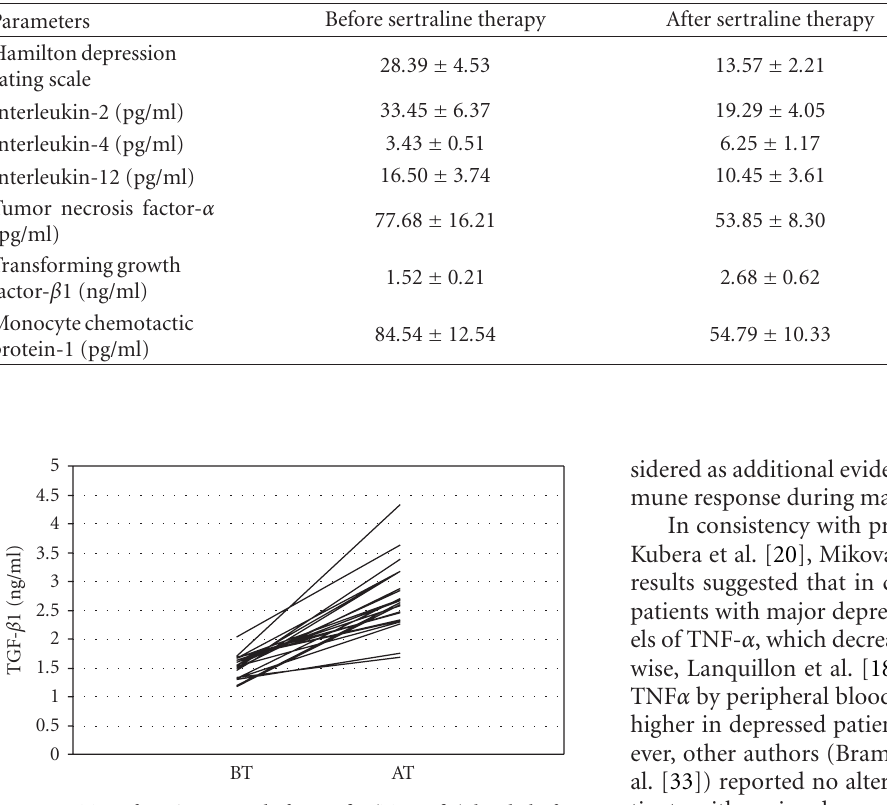
Figure 4: Transforming growth factor β 1 (TGF- β 1) levels before (BT) and after (AT) sertraline